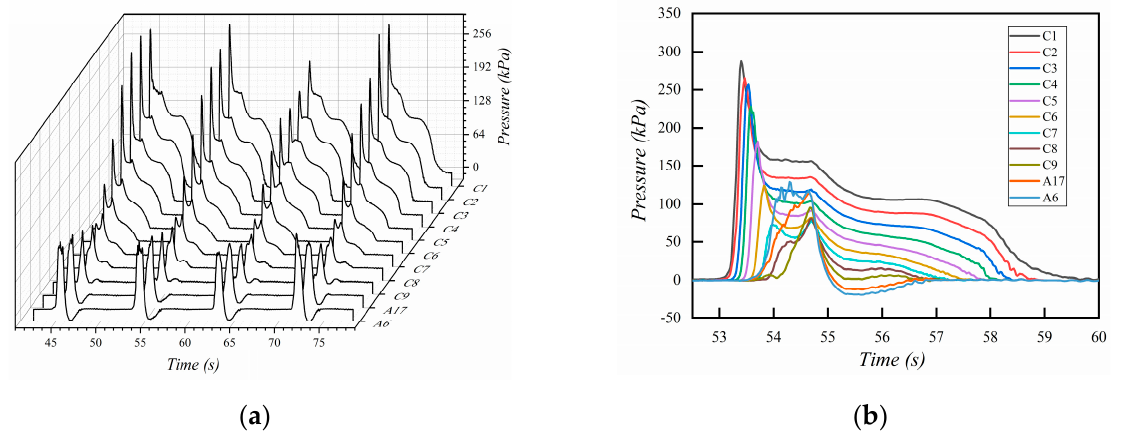
Figure 16. ( a ) Time history of slamming pressure at C1–C9 and A6 and A17 in four periods. ( b ) Time history of slamming pressure at C1–C9 and A6 and A17 in one periods.